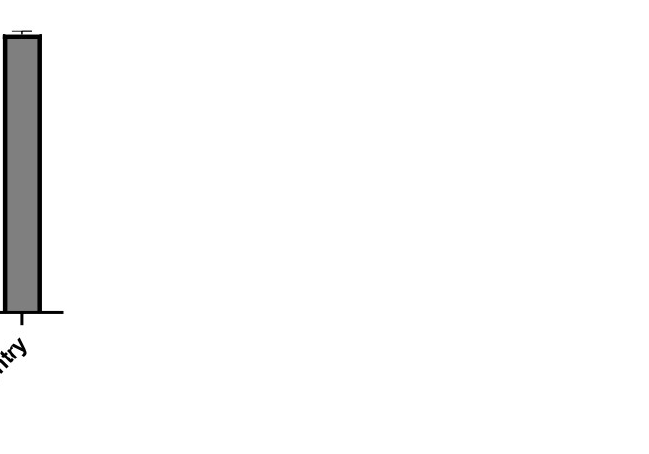
Figure 7. Time of addition assay of Saussurea costus aqueous extract. Vero cells were infected at MOI 1.5 and incubated with the extract at different times during the infection as is described in Section 2. After 24 h.p.i, the virus genome production was quantitated in the supernatant by qPCR. The % of inhibition was determined as the ratio between treated and untreated infected cells. Data are expressed as mean +/− SD for n = 3.